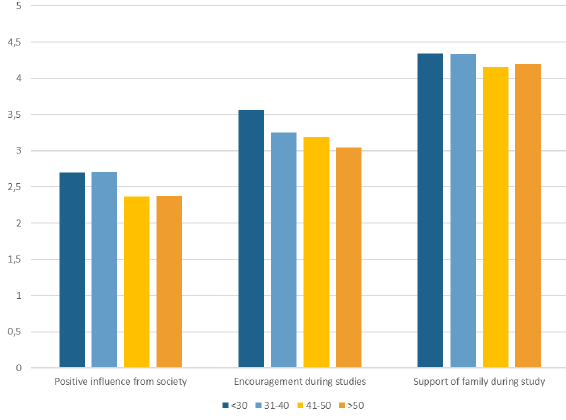
Figure 8. Facilitators related to education depending on